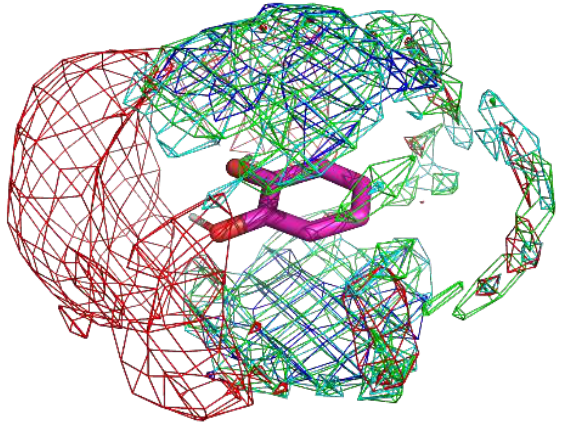
Figure 6. The residue interaction profile of catechol. Green, cyan, gray, blue, and red meshes indicate profiles of hydrophobic, hydrophilic, aromatic, basic, and acidic residues, respectively. The mole- cule structure is that of catechol.